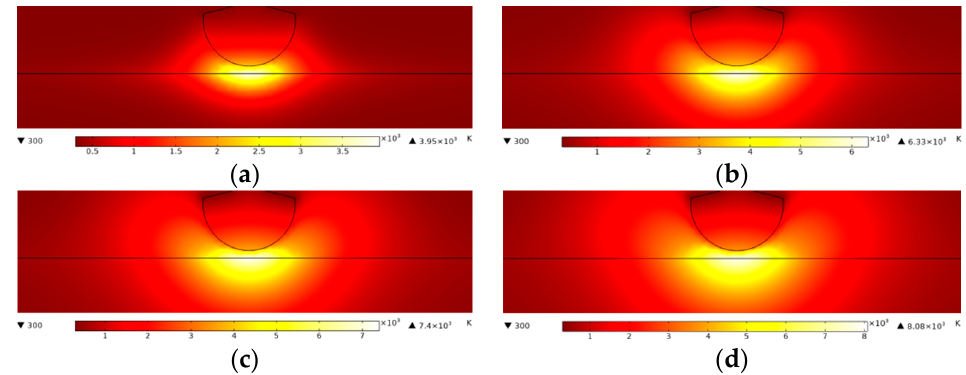
Figure 5. Temperature distribution cloud diagram of the pantograph–catenary arc (when gap is 2 mm). ( a ) 0.1 s cloud chart of arc temperature distribution; ( b ) 0.4 s cloud chart of arc temperature distribution; ( c ) 0.7 s cloud chart of arc temperature distribution; ( d ) 1 s cloud chart of arc temperature distribution.